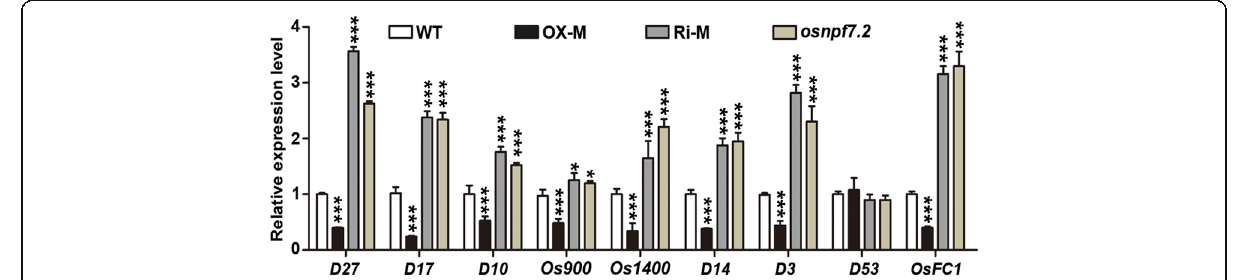
Fig. 6 Expression of genes involved in strigolactone biosynthesis, perception and signalling pathway. Genes ’ expression involved in SL biosynthesis ( D27 , D17 , D10 , Os900 and Os1400 ), perception ( D14 and D3 ), and signalling ( D53 ) were detected among different genetical modified lines. OX-M and Ri-M was same to that in fig. 4d. Date are shown as mean ± SD from three replicates; “ * ” and “ *** ” indicated significant differences at P < 0.05 and P < 0.001,